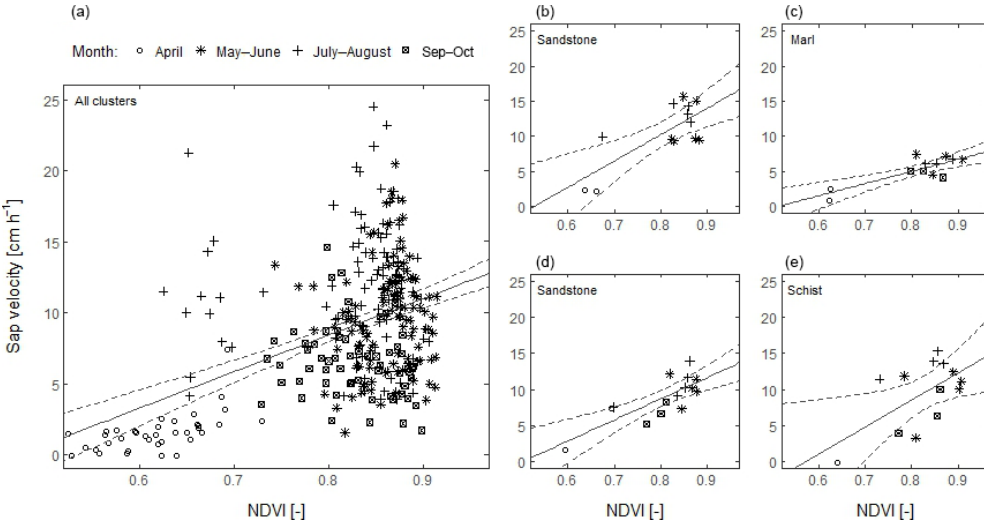
Figure 6. Temporal correlation between sap velocity and NDVI for all 20 studied days in 2014 and 2015. (a) For all sensor clusters together, = 0 . 22). (b–e) The correlation for four different clusters in different sap velocity and NDVI were positively correlated ( p < 0 . 001, R 2 adj geologies. For each shown cluster, the correlation is significant ( p < 0 . 05). For 1 of the 25 clusters, the correlation is not significant, and for 2 clusters the correlation is significant only at p < 0 . 1. The dashed line represents the 95% confidence interval.